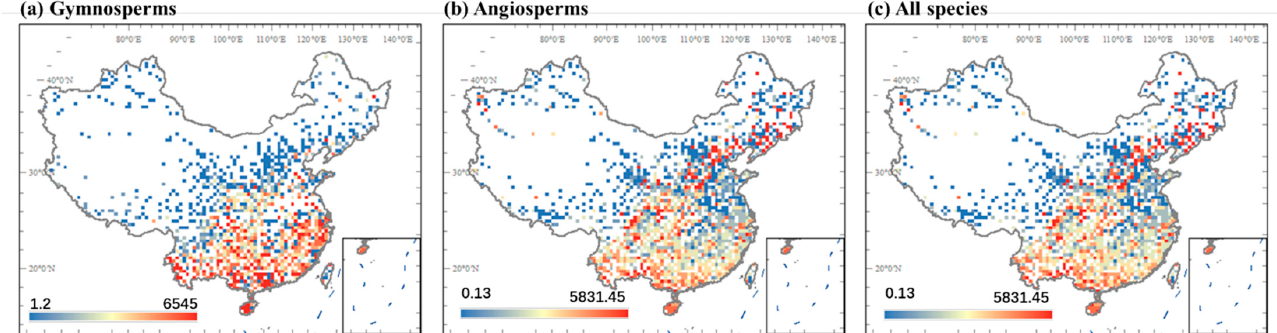
Figure 1. The geographic patterns in the seed mass of woody species in China. ( a ) Gymnosperms; ( b ) angiosperms; ( c ) all species. The value increased from blue to red. The spatial resolution was 50 × 50 km.